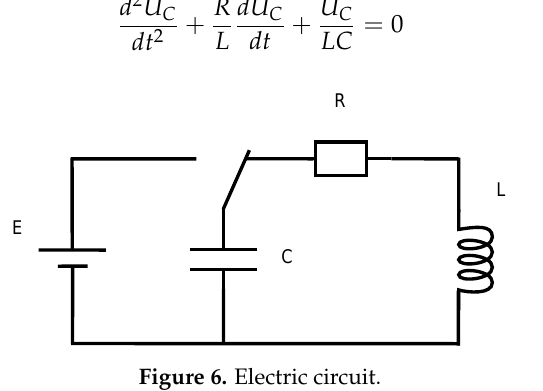
Figure 6. Electric